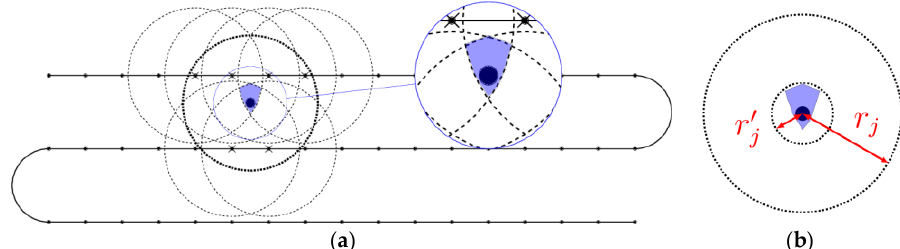
Figure 4. Photogrammetry trajectories for sensor location estimation. Figure 5. Sensor position estimation through a photogrammetry procedure (with highlight for the uncertainty radius). ( a ) estimation detail; ( b ) uncertainty range.